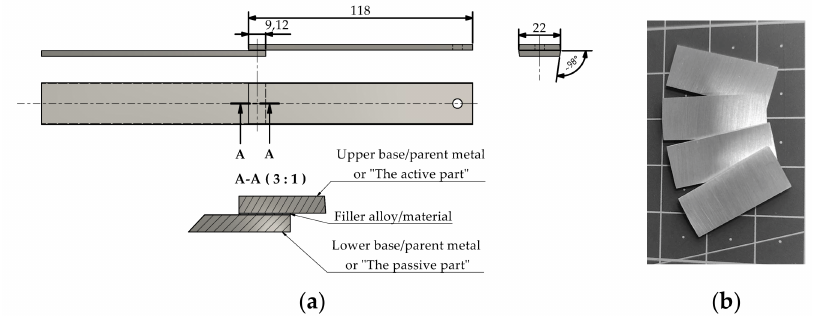
Figure 3. Brazing assembly: ( a ) Brazing assembly components and dimensions (mm), where A–A is the cross-section for the microstructures observation, the examined location during this study is close to the middle of the section A-A if not reported differently; ( b ) The form of the filler